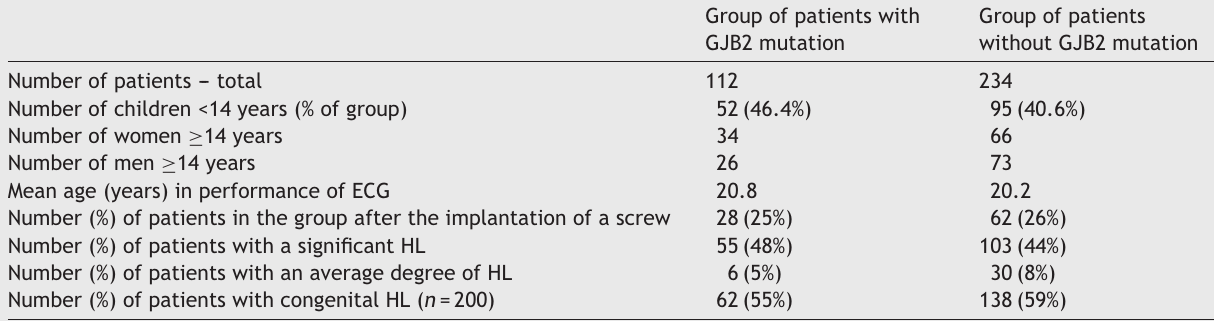
Characteristics of the group of patients diagnosed with mutations in gene GJB2 (genotype homozygous and heterozygous together) and the group of patients without any mutation in the gene. Group of patients with